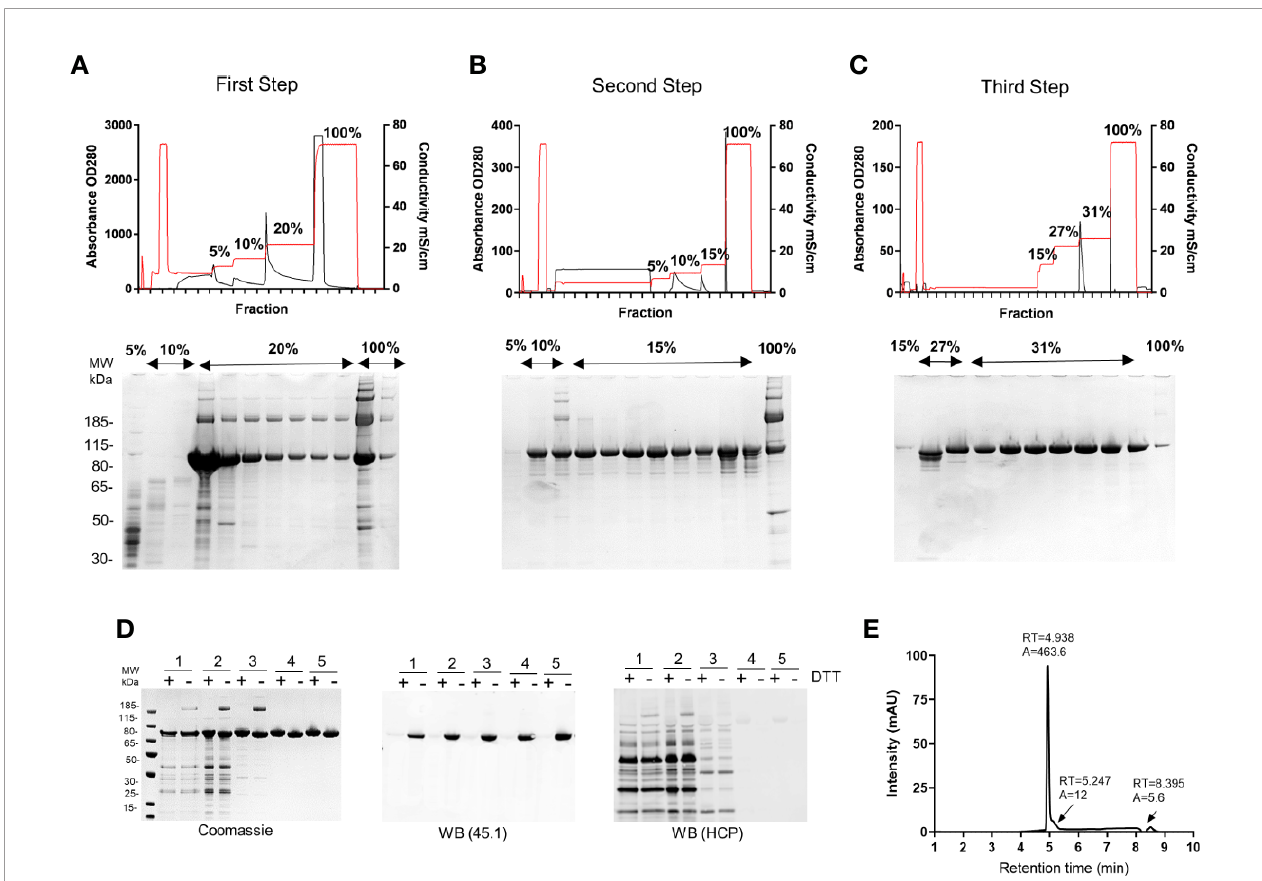
FIGURE 2 | Production of R0.6C in L. lactis . Elution pro fi les of R0.6C on (A) First step; HiPrep Q HP column, (B) Second step; HiPrep SP HP column, and (C) Third step; HiPrep Q HP. Selected fractions were analysed on 4% – 12.5% polyacrylamide gels shown below the chromatograms. Protein was loaded without a reducing agent. (D) Analysis of R0.6C by SDS-PAGE. Left panel Coomassie blue-stained 4% – 12.5% polyacrylamide gel; 1 Fermented supernatant 2 Dia fi ltrate, 3 HiPrep Q HP column, 4 HiPrep SP HP column, 5HiPrep Q HP column puri fi ed R0.6C. An immune blot analysis of the same gel shown in the left panel using mAb45.1 and anti- L. lactis antibodies (detection of HCP) in the middle and right panels , respectively. Protein was loaded in each lane with (+) or without ( − ) DTT (10 mM). The sizes (kDa) of the molecular mass markers are indicated. (E) Reverse-phase (RP) HPLC. Reversed-phase HPLC – UV chromatogram recorded following analysis of puri fi ed R0.6C. The peak at 4.938 min corresponds to monomeric R0.6C antigen. A denotes integrated peak area, and RT indicates retention